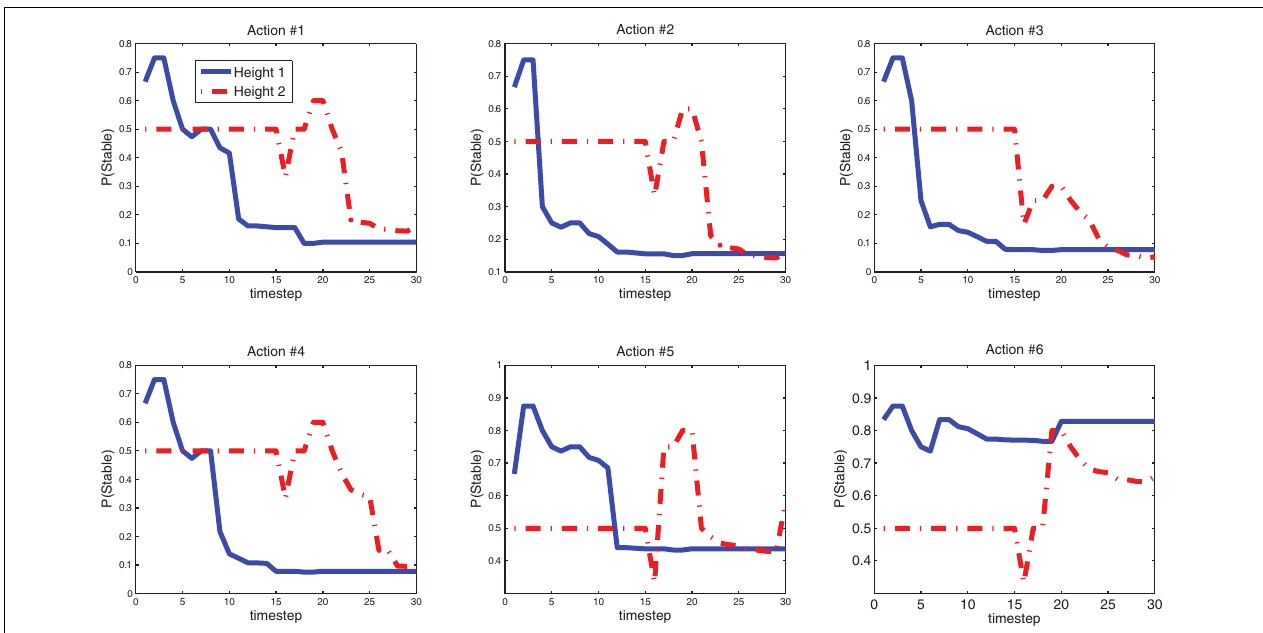
FIGURE 13 | Learning progress of the Katana robot arm’s predictive models at height 1 and 2 after 30 settings. Action 1 (no bits set) is the most unstable. Action 6 (all bits set) is the most stable. See earlier discussion on the features and Figure 2 .